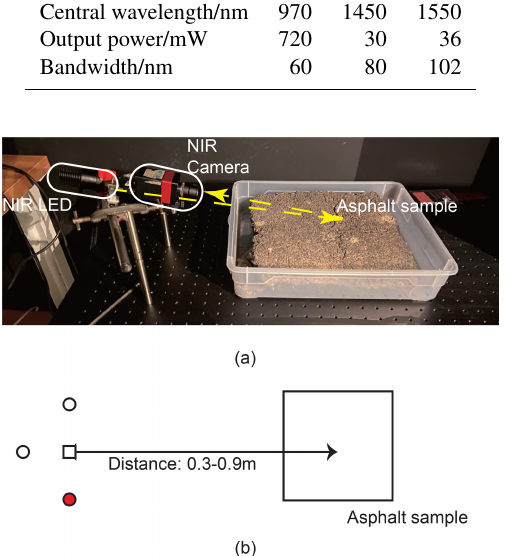
Figure 11. (a) Picture of the experimental setup. (b) Top-view sketch of the experimental setup. The square represents the fixed position of the camera. The circles represent the different positions of the LED sources. For example, the configuration of (a) represents the case where the LED sources are positioned on the red circle.